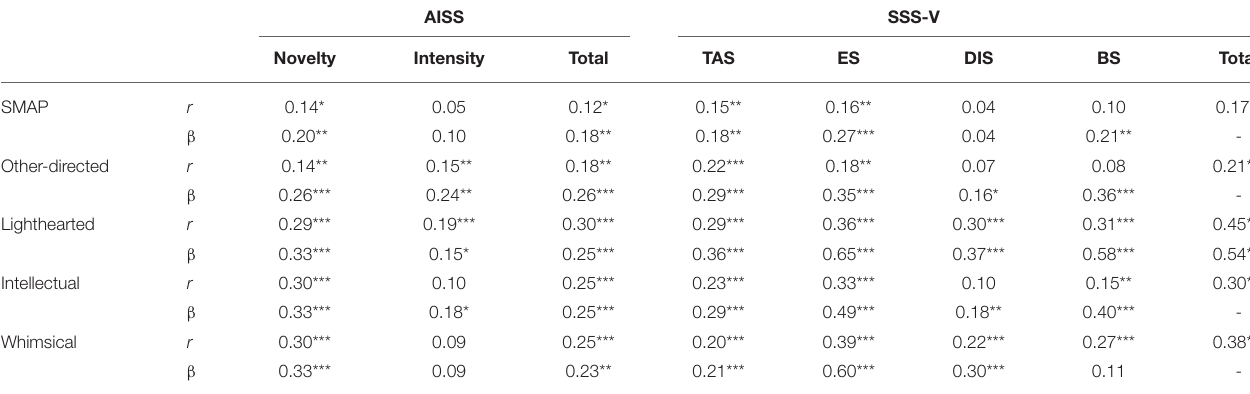
TABLE 3 | Associations between playfulness and sensation-seeking scales in 339 librarians in correlation ( r ) and SEM analyses ( β ). AISS SSS-V Novelty Intensity Total TAS ES DIS BS Total